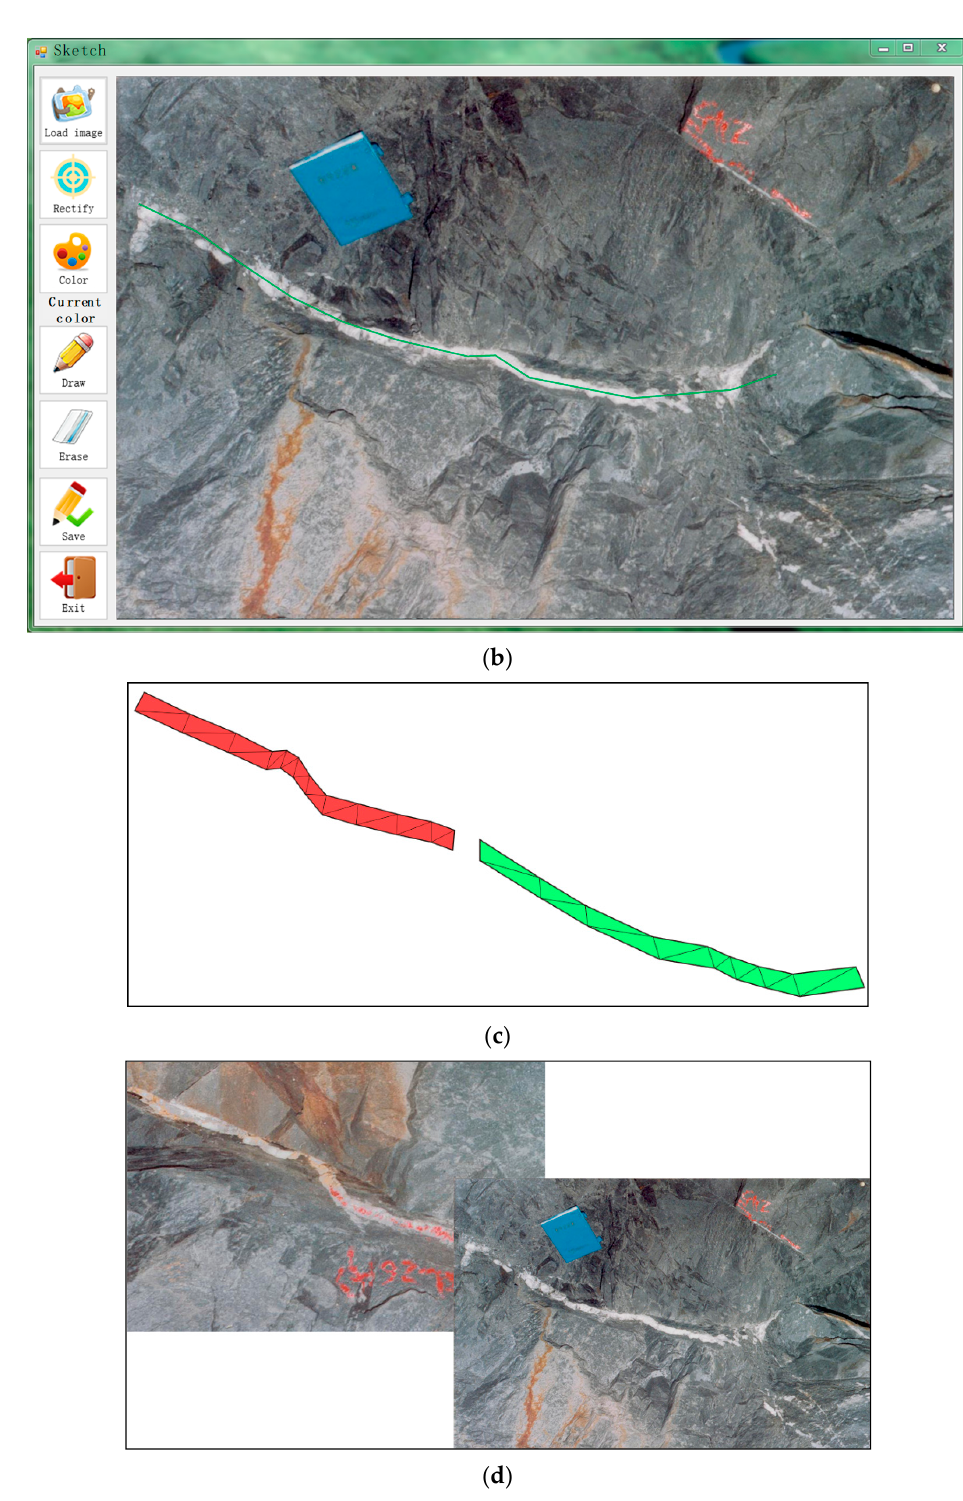
Figure 17. Two-dimensional image interpretation: labelling ( a ) strata I and ( b ) strata II; ( c ) 3D models of strata I and II loaded in a 3D modeling software; ( d ) two stitched images of strata I and II.